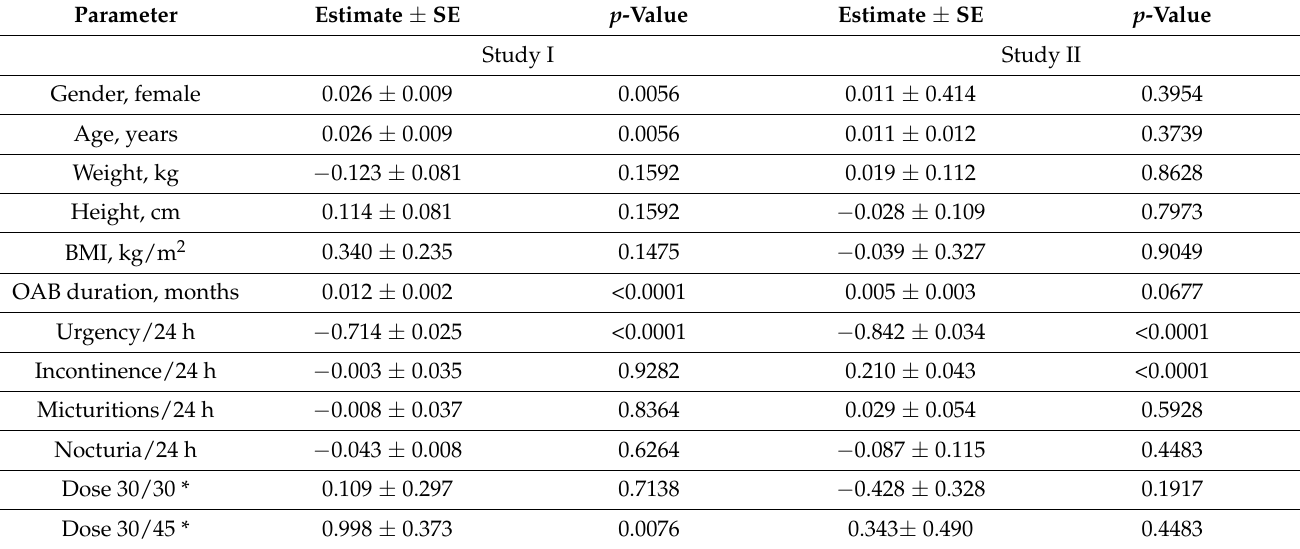
Table 5. Factors associated with overall improvement of urgency (12 weeks vs. baseline) in a logistic regression analysis taking demographics, OAB parameters at baseline, duration of condition and dose level into consideration.